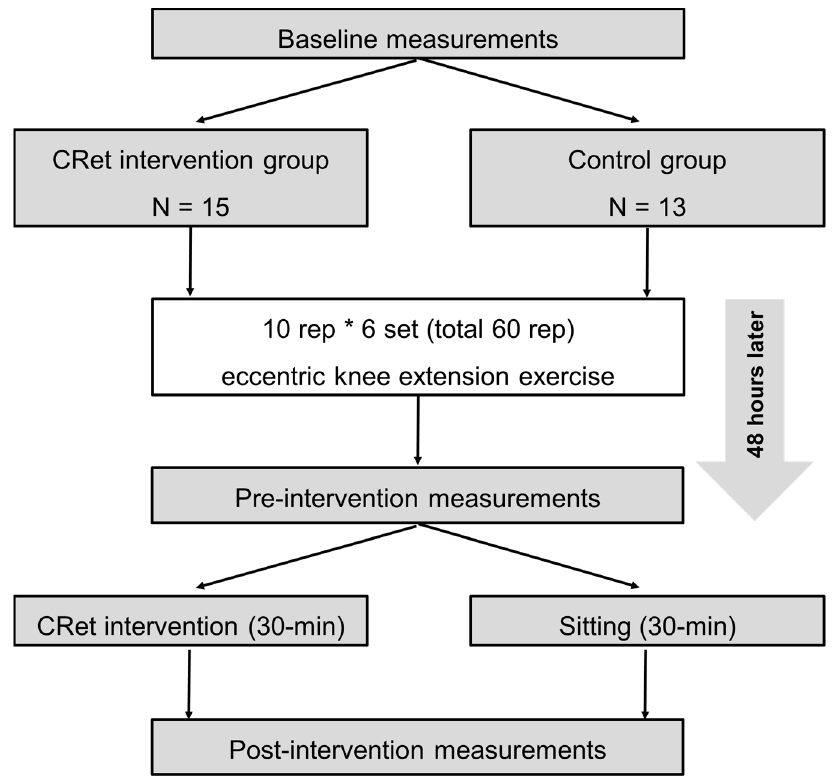
Figure 1. Experimental Design.